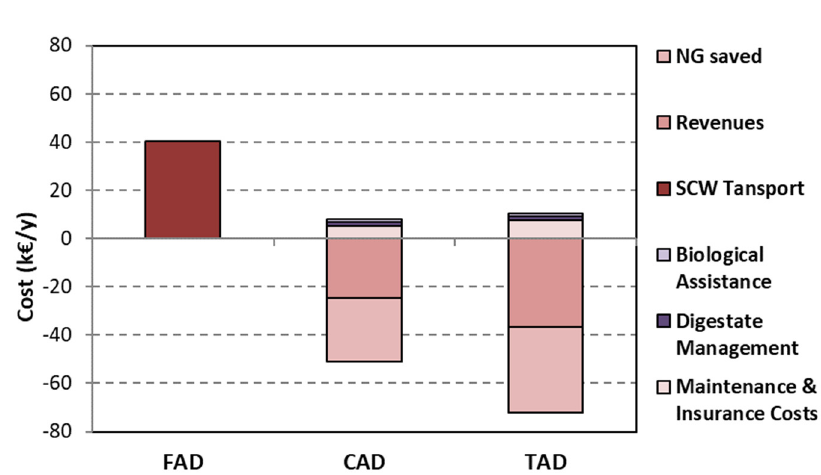
Figure 2. Opex expenditures: annual cost contribution analysis.